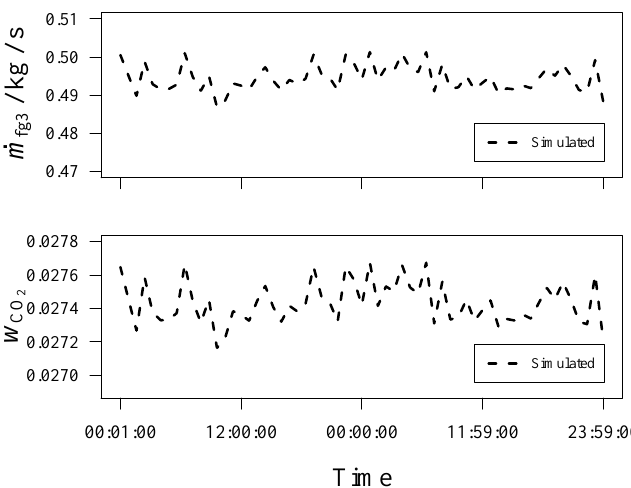
Figure 13. ( Top ) Mass flow of exhaust gases vs. time; ( Bottom ) Mass fraction of CO 2 vs. time. The simulated values were obtained by means of the input signals specified in Figure